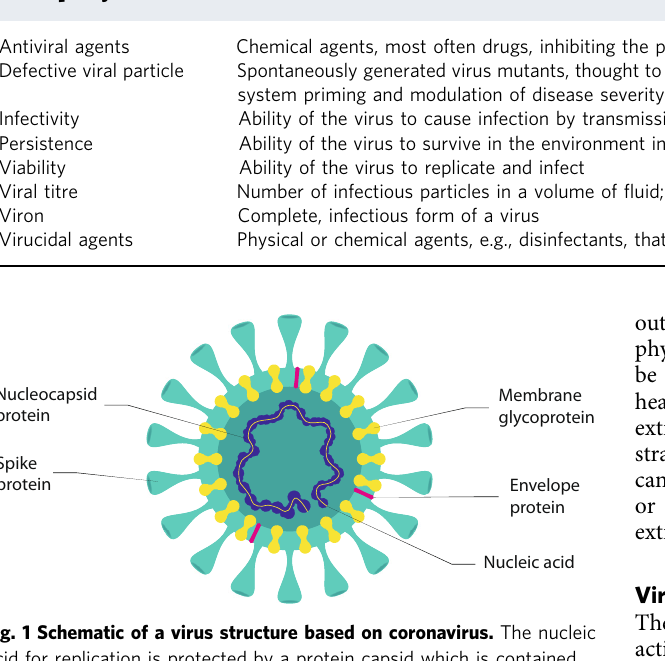
Table 2. The methods can be divided into three general groups: (1) cell-based assays to measure viral infectivity, (2) gene or protein expression assays to detect virus presence and (3) direct count of viral particles.